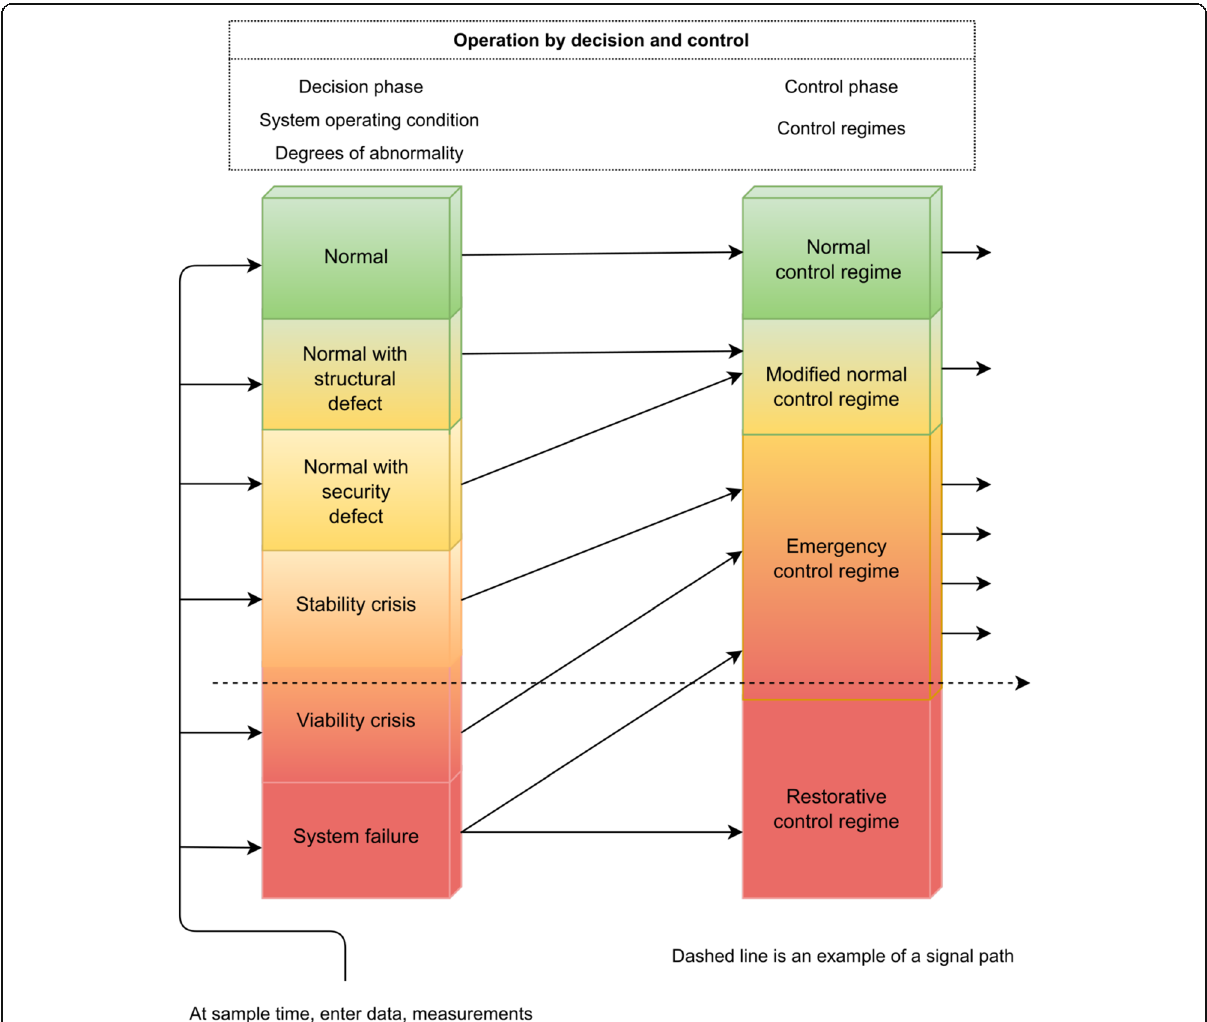
Fig. 1 Dependence of the appropriate decision and control regime on the system operating condition after Ili ć and Zaborski [21] as depicted by Koch et al.